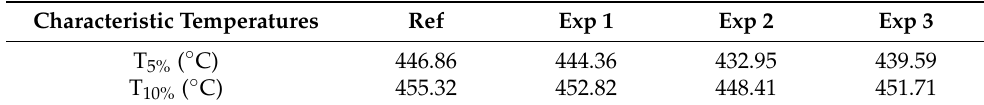
Table 6. Thermal degradation temperatures for virgin and aged